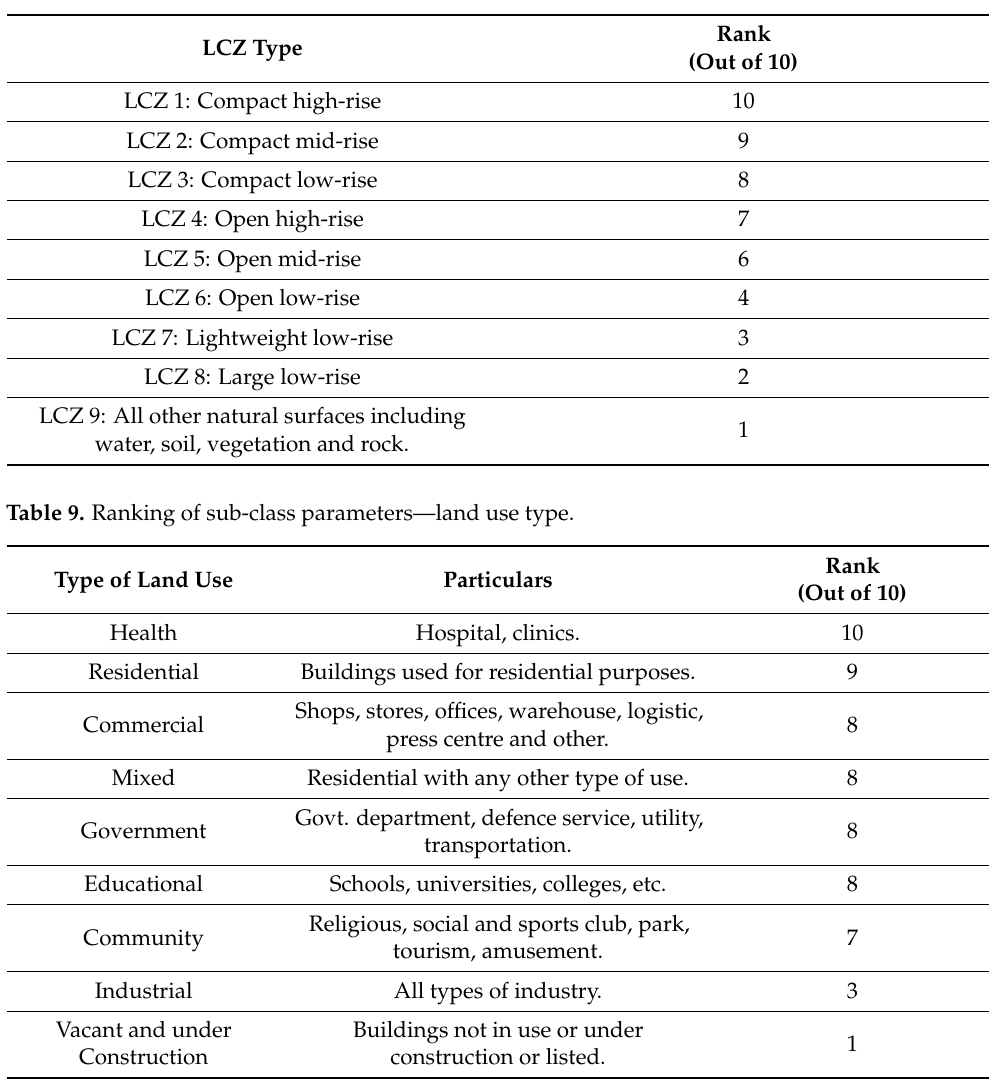
Table 8. Ranking of sub-class parameters—LCZ class (see [56] for details of LCZ classes).